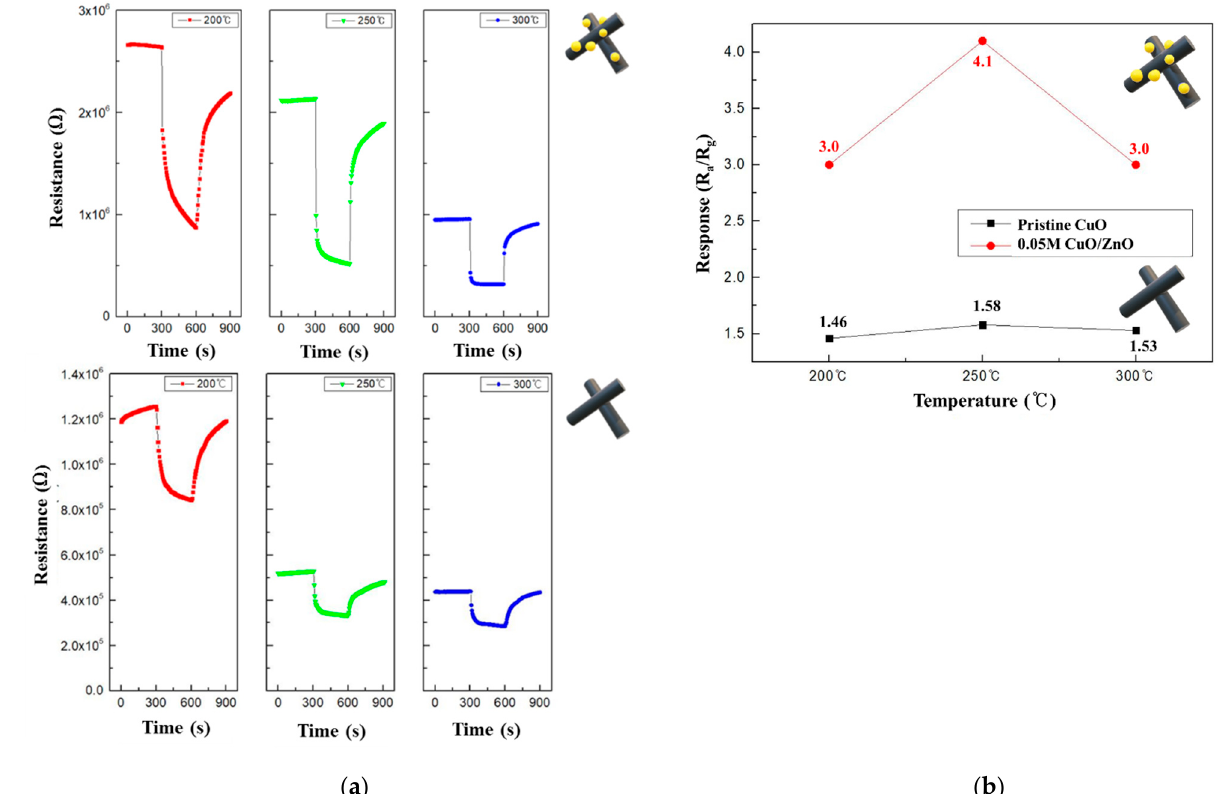
Figure 9. ( a ) Summary of the pristine CuO and 0.05 M CuO/ZnO responses to 100 ppm NO 2 at 200-300 °C; ( b ) Response curves of the pristine CuO and 0.05 M CuO/ZnO to 100 ppm NO 2 at 200–300 °C.